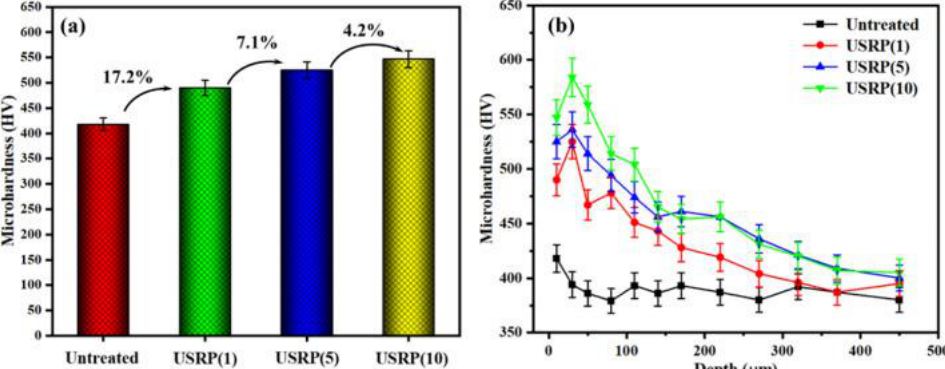
Figure 12. Microhardness profiles of untreated and USRP’ed 300M steel after 1, 5, and 10 passes ( a ) depth. Reprinted with permission from ref. [28]. Copyright 2021